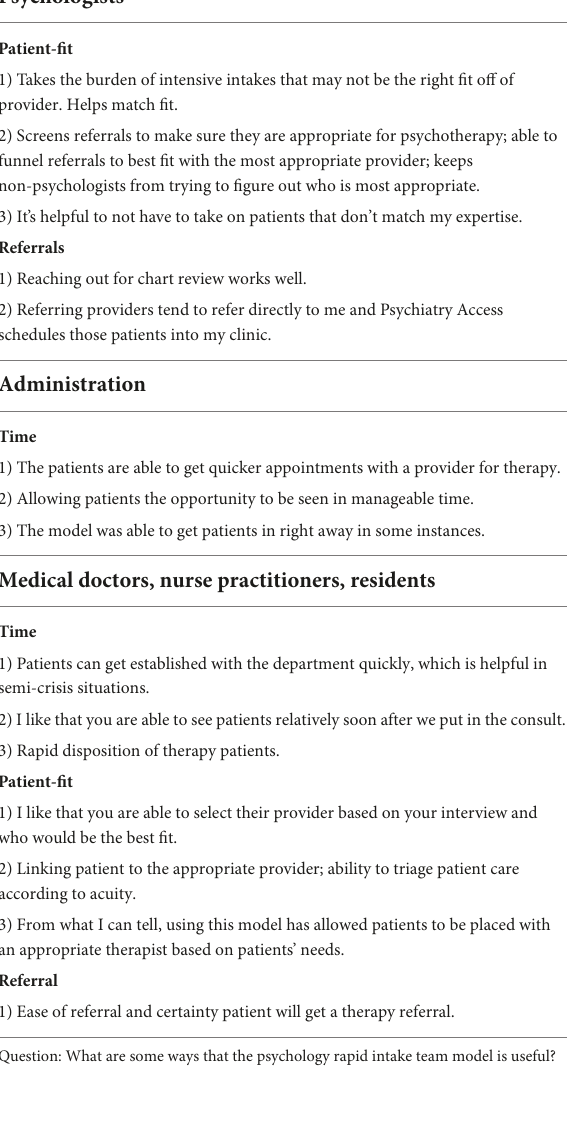
TABLE 1 General employee reported themes about the impact of the rapid intake